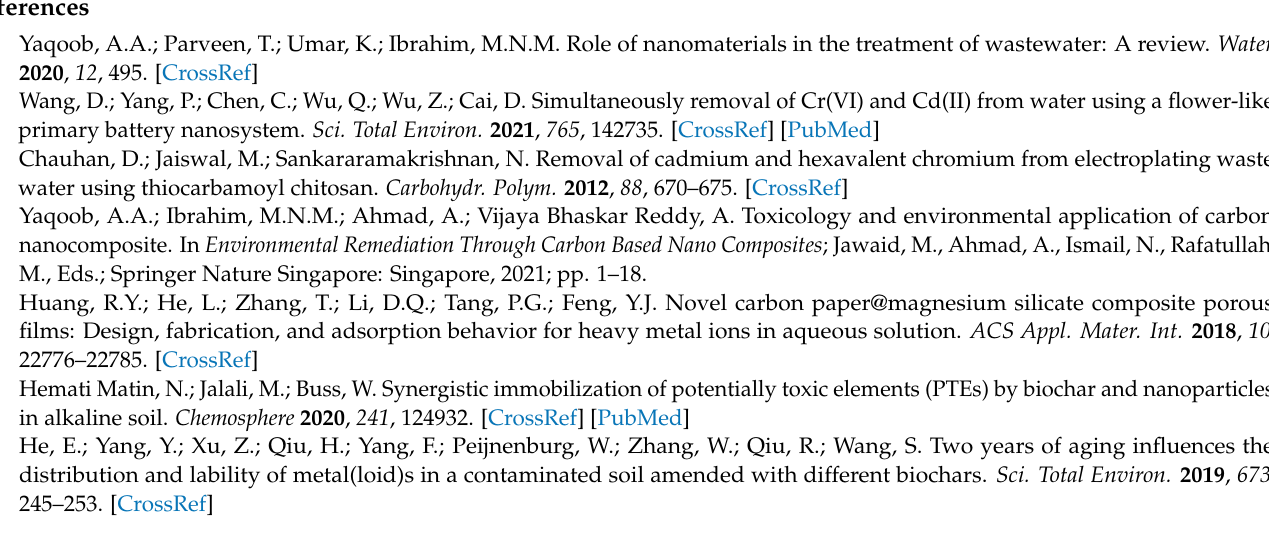
tures; Table S2: Comparison of the adsorption capacities of Cr(VI) and Cd(II) by different adsorbents; Table S3: Assignment of the vibrational bands in the FTIR spectra. References [58–62] are cited in Supplementary